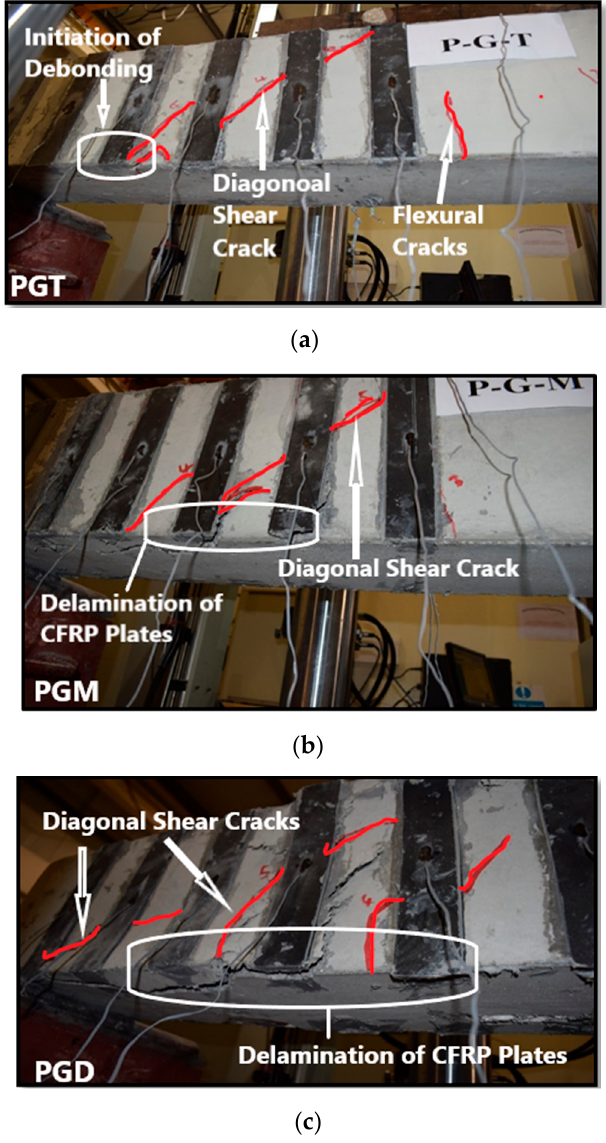
Figure 8. Failure modes: ( a ) PGT beam; ( b ) PGM beam; ( c ) PGD beam.